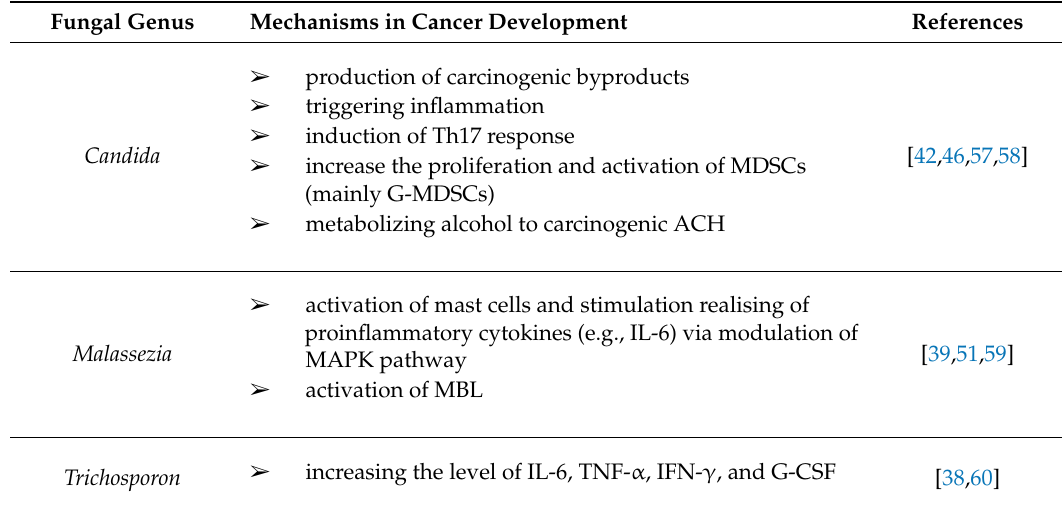
Table 1. The role of main fungal genera in carcinogenesis